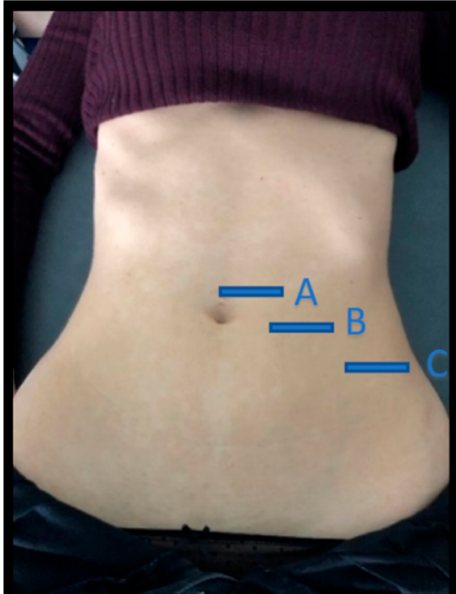
Figure 1. Location of the three abdominal imaging points, from lateral to medial: (A) midway between the iliac crest and the lower edge of the ribcage, in the axillary midline for the EO, IO, and TrAb; (B) over the midpoint of the AR muscle, at the level of the umbilicus; (C) in the midline of the abdomen just above the umbilicus for the IRD. EO—external oblique; IO—internal oblique; TrAb—transverse abdominal; AR—abdominis rectus; IRD—inter-rectus